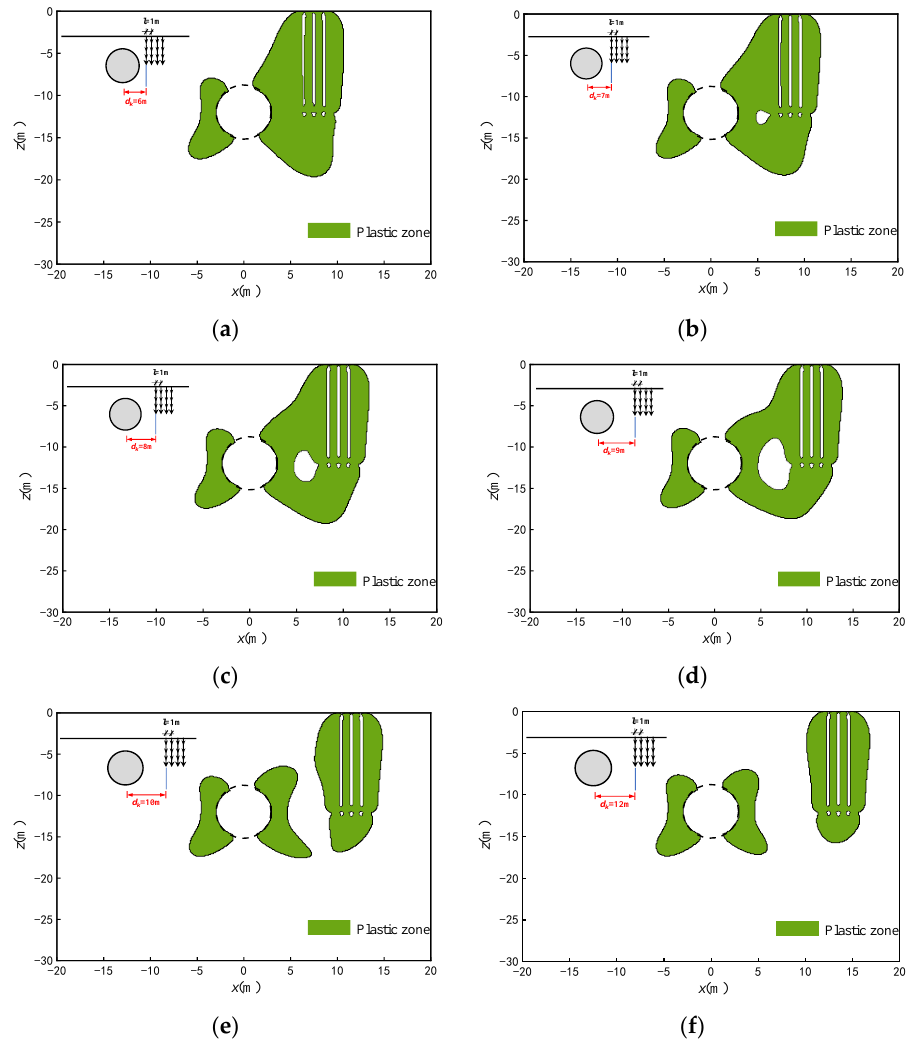
Figure 10. Potential plastic zones for different offsets d k of the pile group from the tunnel: ( a ) d k = 6m; ( b ) d k = 7m; ( c ) d k = 8m; ( d ) d k = 9m ( e ) d k = 10m; ( f ) d k = 12m.